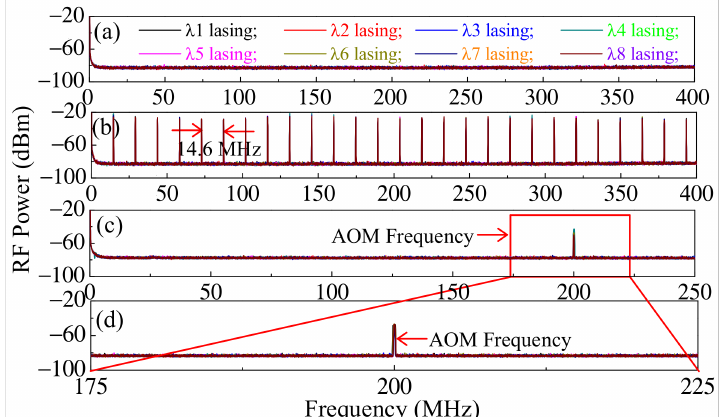
Figure 5. RF spectra of each single-wavelength lasing measured by the self-homodyne method using ( a ) MH mode in a range of 0–400 MHz for 10 min with a resolution bandwidth (RBW) of 51 kHz; and ( b ) MH mode in a range of 0–400 MHz for 10 min with an RBW of 51 kHz when the F-P and SCR filters are replaced by an SMF having the same efficient length. RF spectra measured by the delayed self-heterodyne method for almost 30 min using the MH mode are in ( c ) 0–250 MHz, with an RBW of 51 kHz; and ( d ) 175–225 MHz, with an RBW of 30 kHz.